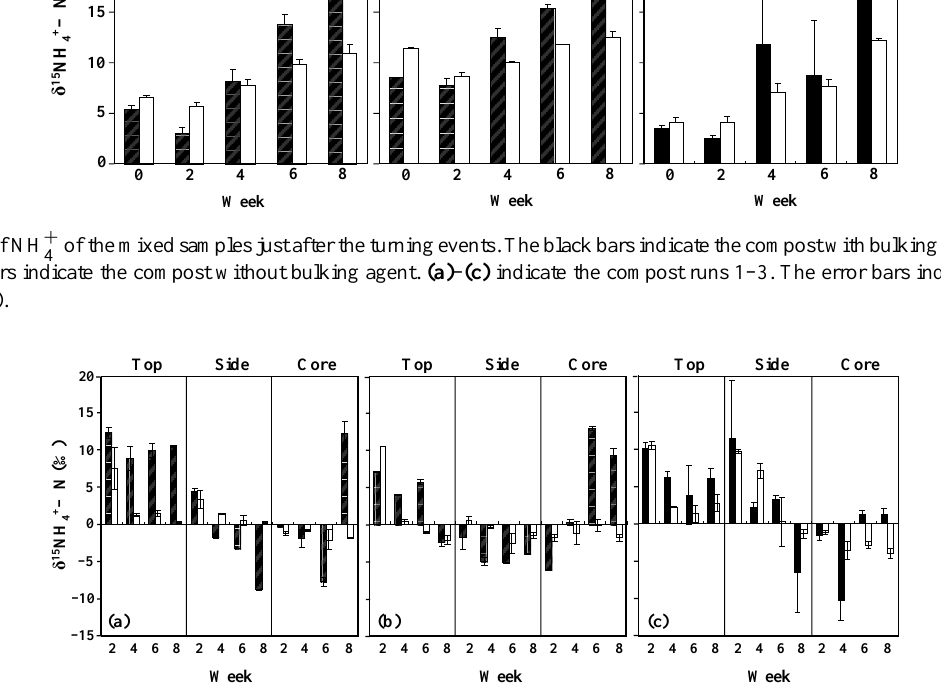
dropped significantly from 23 . 8 ± 3 . 3 to 12 . 8 ± 0 . 8 and from 22 . 8 ± 1 . 2 to 15 . 6 ± 2 . 6, respectively. These parameters all indicate that the organic matter degradation rate was much higher in the piles with bulking